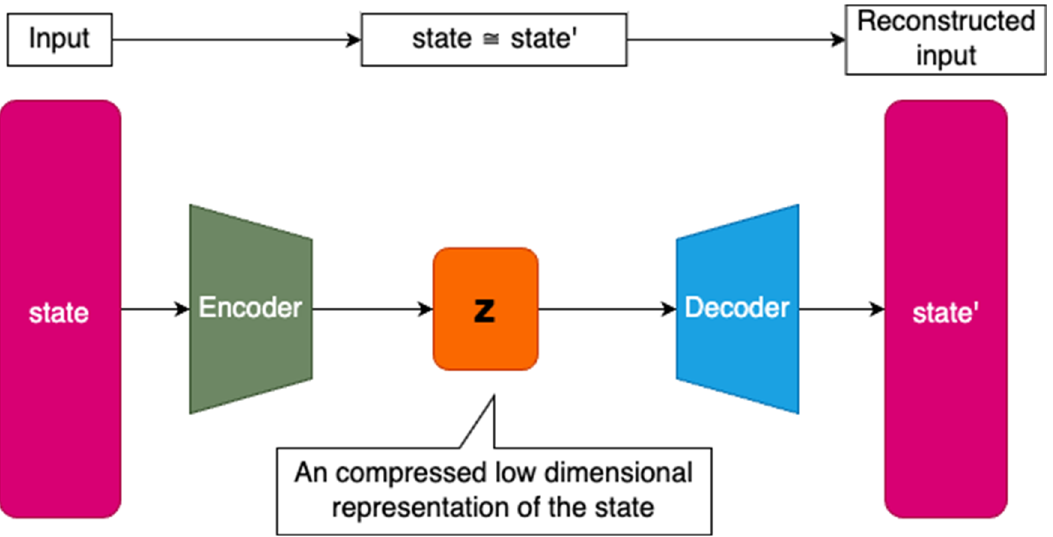
Figure 1. AutoEncoder model with size of the layers indicating the number of neurons in the layers, where the smallest layer z in the middle corresponds to low-dimensional latent space representa- tion.